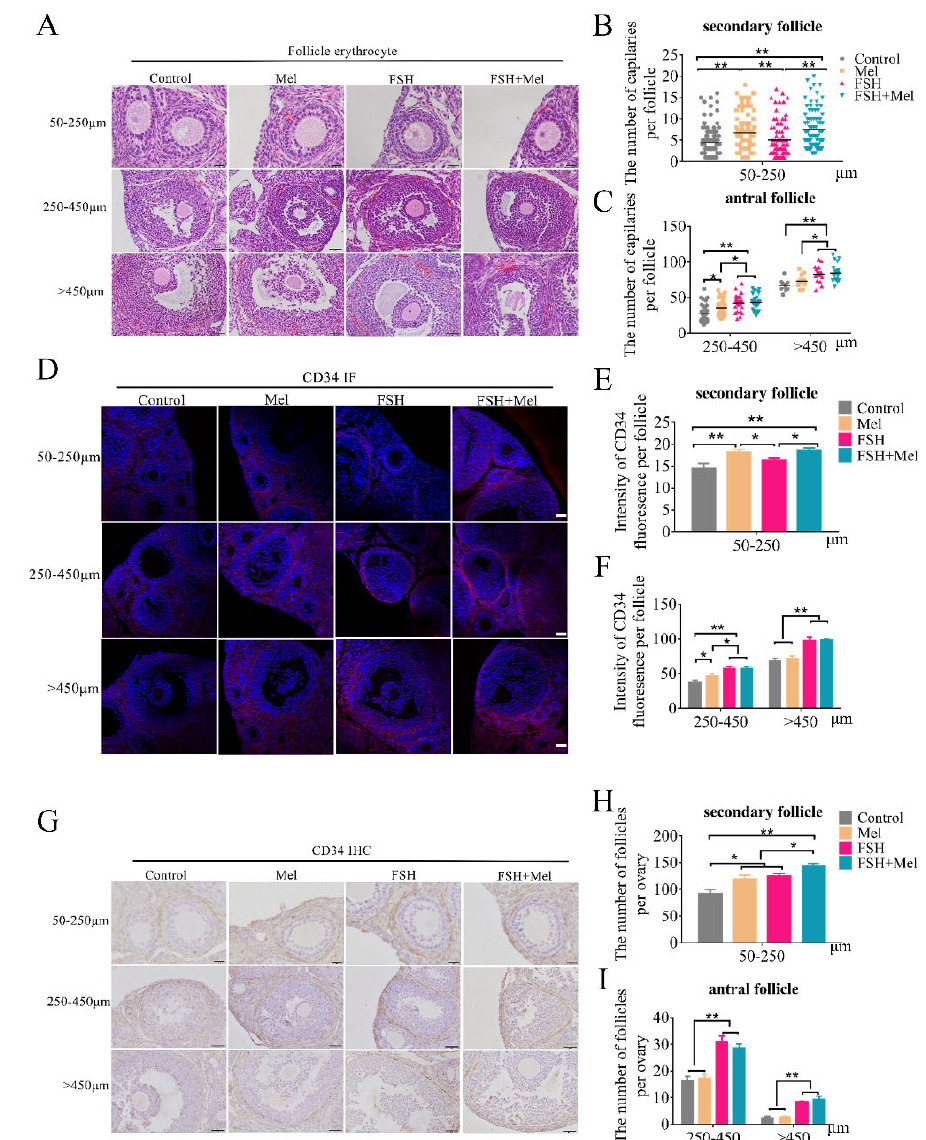
Figure 1. Effect of Mel and FSH on the number of follicles and erythrocytes and the expression of CD34 around follicles in different follicular development stage of mice ovaries. ( A ) Erythrocytes around follicles in different follicular development stage of mice ovaries detected by hematoxylin- eosin (H&E) staining. Scale bar = 20 µ m in 50–250 µ m follicles, scale bar = 50 µ m in above 250 µ m follicles. ( B ) Statistical analysis of the amount of erythrocytes in 50–250 µ m follicles. ( C ) Statistical analysis of the amount of erythrocytes in above 250 µ m follicles. ( D ) The expression of CD34 around follicles in different follicular development stage of mice ovaries detected by immunofluorescence (IF). Scale bar = 50 µ m. ( E ) Statistical analysis of the expression of CD34 in 50–250 µ m follicles. ( F ) Statistical analysis of the expression of CD34 in above 250 µ m. ( G ) The expression of CD34 around follicles in different follicular development stage of mice ovaries detected by immunohistochem- istry (IHC). Scale bar = 20 µ m in 50–250 µ m follicles, scale bar = 50 µ m in above 250 µ m follicles. ( H ) Statistical analysis of the number of follicles in 50–250 µ m follicles. ( I ) Statistical analysis of the number of follicles in above 250 µ m follicles. Horizontal bars denote treatments differing p < 0.05 *, p < 0.01